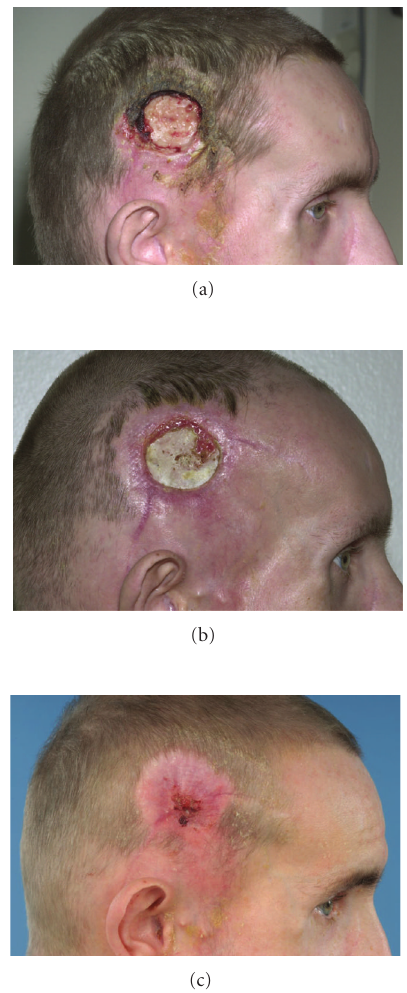
Figure 7: Lesion after 5 weeks (a), 10 weeks (b), and 12 months